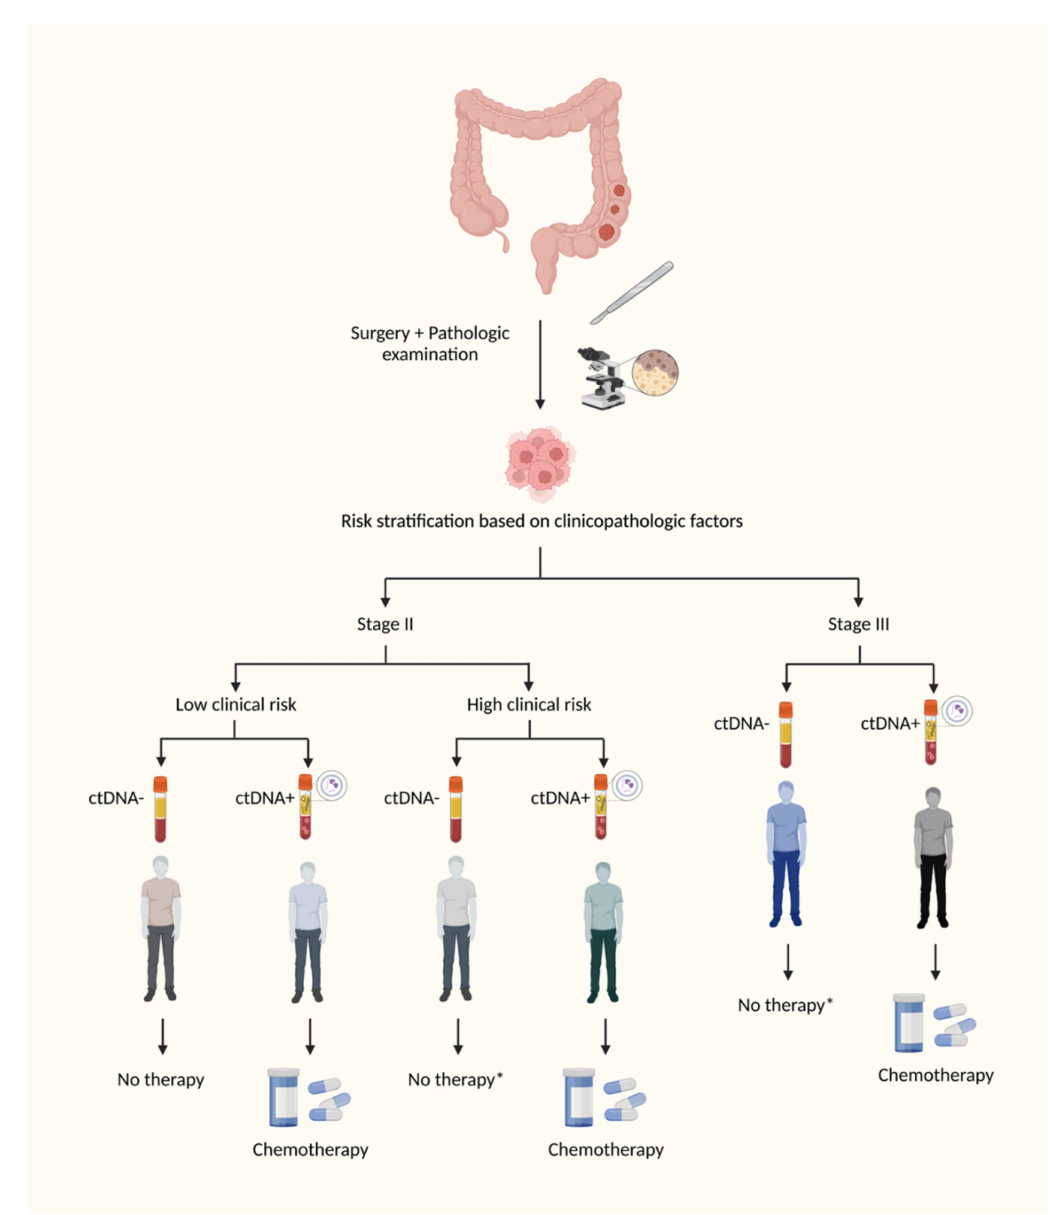
Figure 3. Potential ctDNA-guided postoperative management. This figure illustrates a potential therapeutic algorithm for the decision of adjuvant therapy in colon cancer after the advent of molecu- lar techniques for the detection of minimal residual disease. Certain clinicopathologic factors, such as T4 tumors, have demonstrated significant prognostic value, even in ctDNA-negative patients. Based on the available clinical data, even with the improvement of molecular techniques, it is unlikely that the test will reach very high levels of sensitivity in the first postoperative weeks, when the decision to offer adjuvant chemotherapy has to be made. Hence, it is possible that the combination of molecular (ctDNA) and clinical data might be a reasonable strategy to offer a more personalized therapy for patients with localized colon cancer. * De-escalation of adjuvant chemotherapy in high clinical risk ctDNA-negative patients will only be possible after the development of techniques with very high sensitivity. Created with